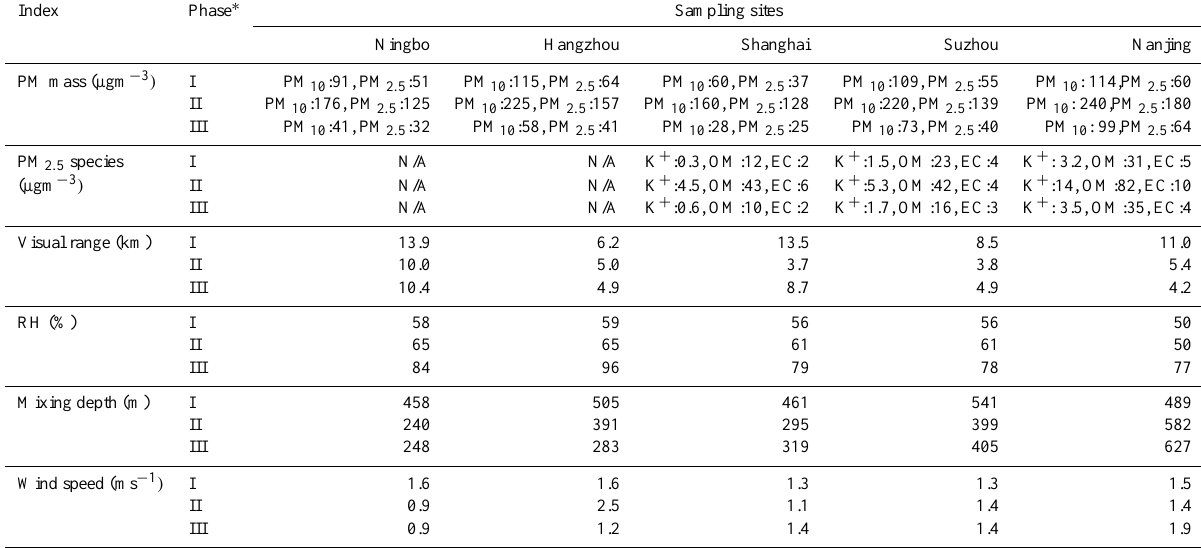
Table 1. PM mass concentration, visual range and meteorological parameters for three phases of the pollution episode.